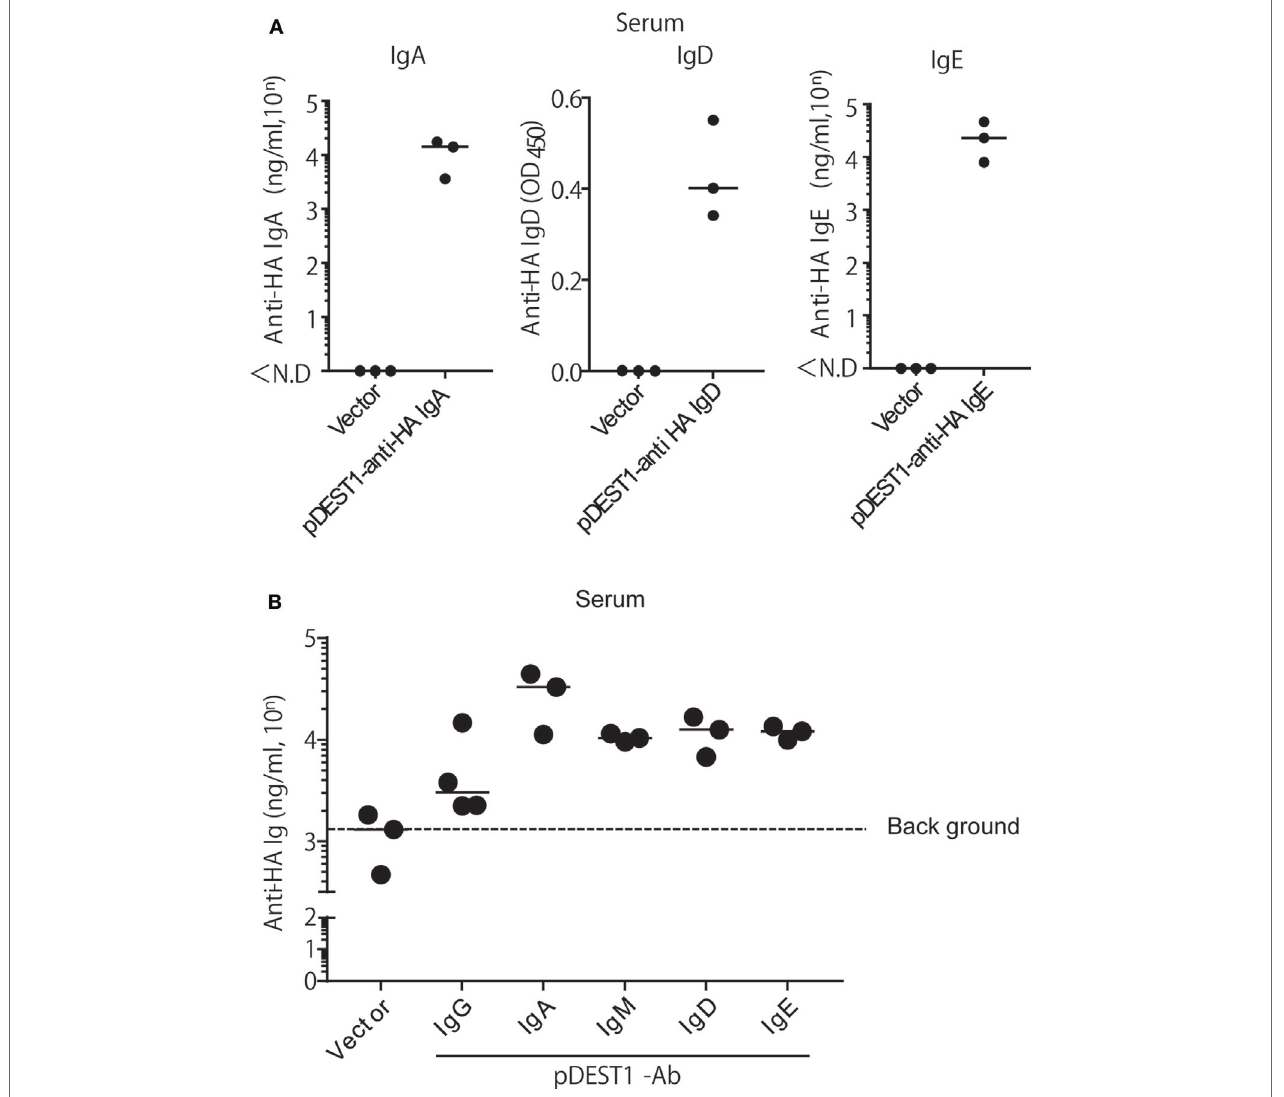
FigUre 5 | HD induces the expression of all isotypes of anti-HA antibodies in the serum. (a) HD was conducted in BALB/c mice and after 1 day, serum was obtained. The expression of each antibody isotype was determined by ELISA using HRP-conjugated got anti-mouse IgA, IgE, or APC-conjugated rat anti-mouse IgD followed by HRP-conjugated anti-rat IgG. (B) The expression level of each isotype was determined by competitive ELISA. A 96-well plate coated with A/PR8-HA, was incubated with the serum samples, followed by biotin-conjugated anti-HA IgG. Data were analyzed using a non-parametric Kruskal–Wallis test ( p = 0.0457). Horizontal bar represents the median. The indicated data are representative of two independent